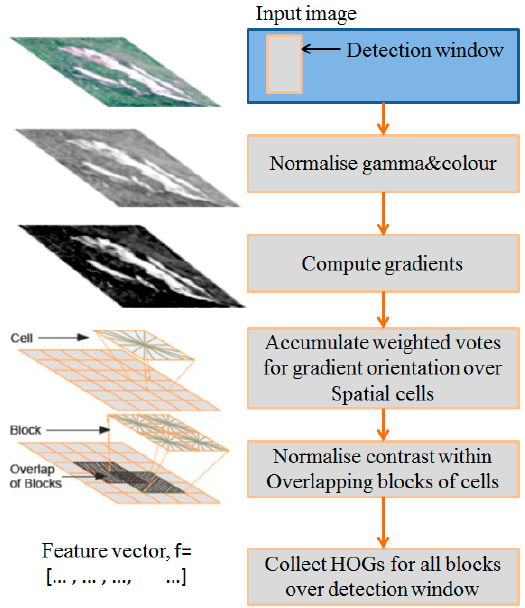
Figure 3. The flow chart of Histograms of Oriented Gradients (HOG) feature